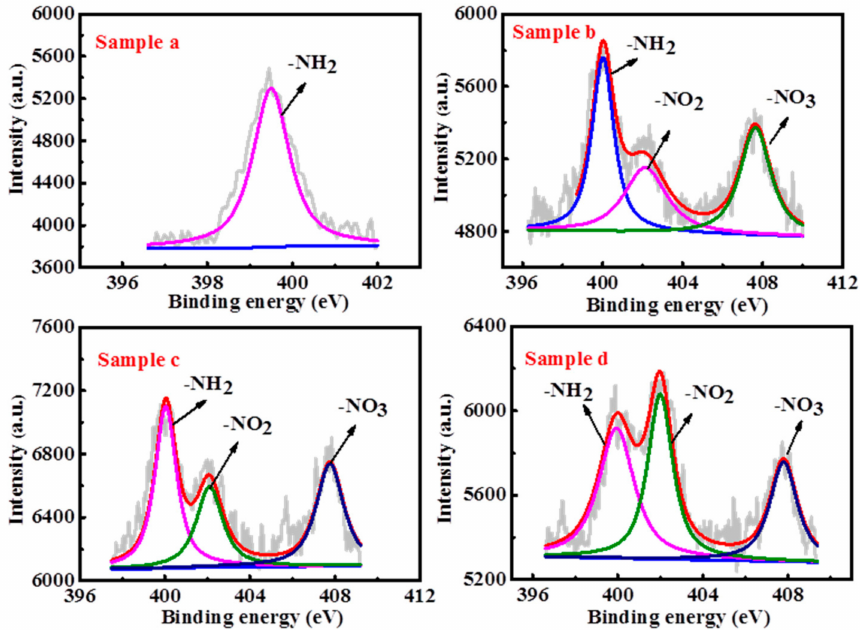
Figure 3. The XPS N 1s spectra of pristine BOPP film and corona BOPP film for di ff erent samples. Based on the test results of ATR-FTIR and XPS, the involved chemical reactions of corona BOPP film are summarized in detail. Corona discharge treatment refers to complex reaction